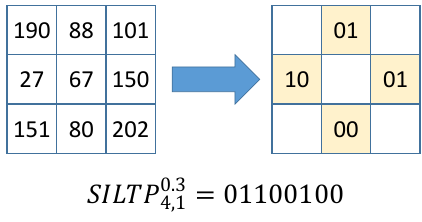
Figure 5. Example of SILTP code calculation. Each cell of the histogram represents the probability of occurrence of a pattern in a sub-window. LOMO is able to deal with viewpoint changes because all sub-windows are checked at the same horizontal location, and the local occurrence of each